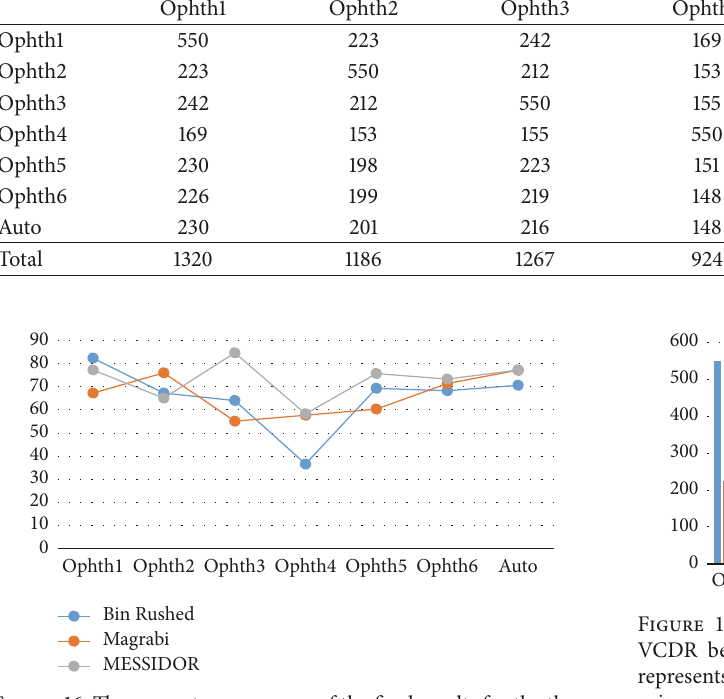
Figure 16: The percentage accuracy of the final results for the three datasets.